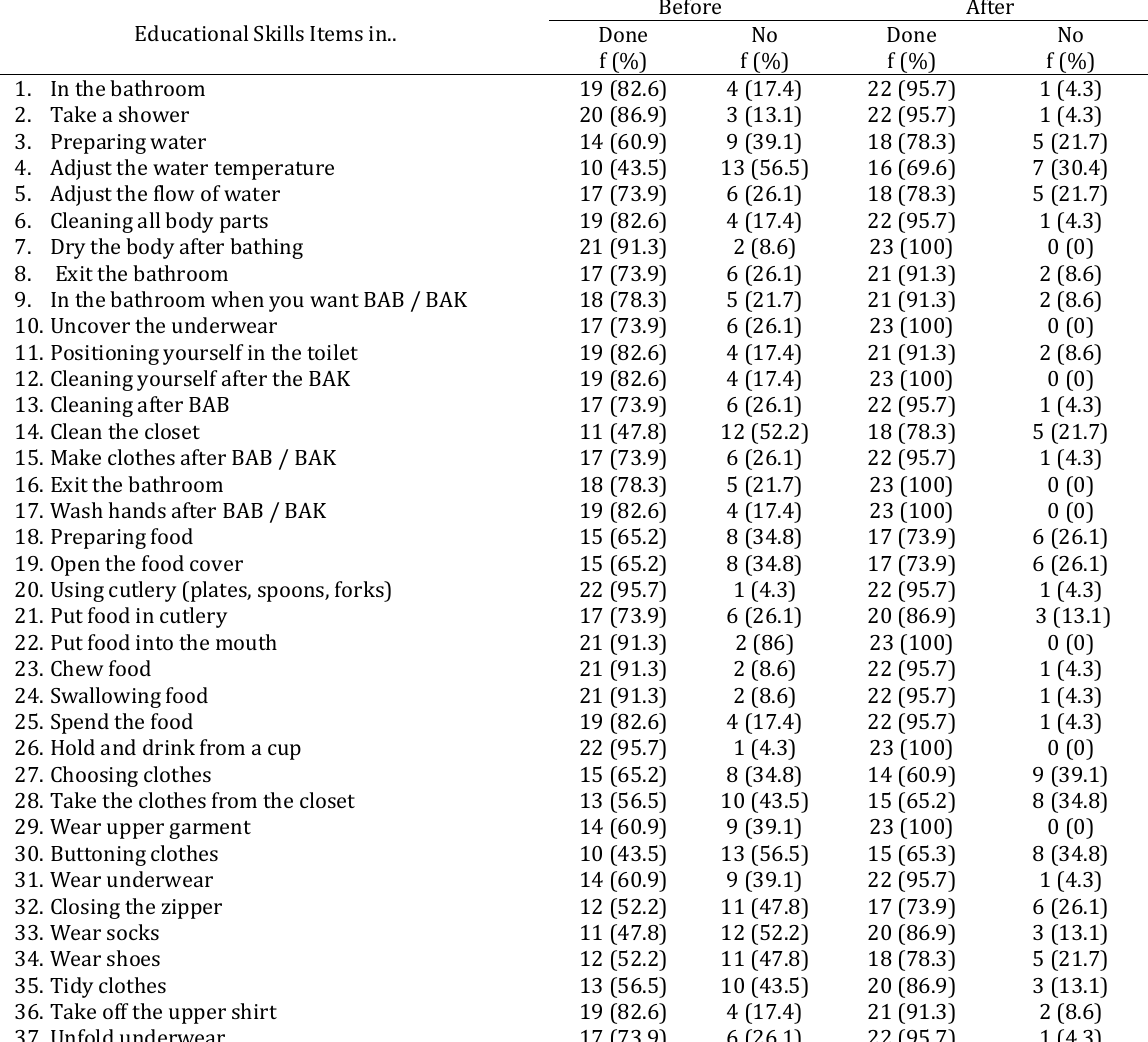
Table 6. Descriptions of Before and After Skills Self-Care Training of a Physically Disabled Child's Caregiver (n= 23) Educational Skills Items